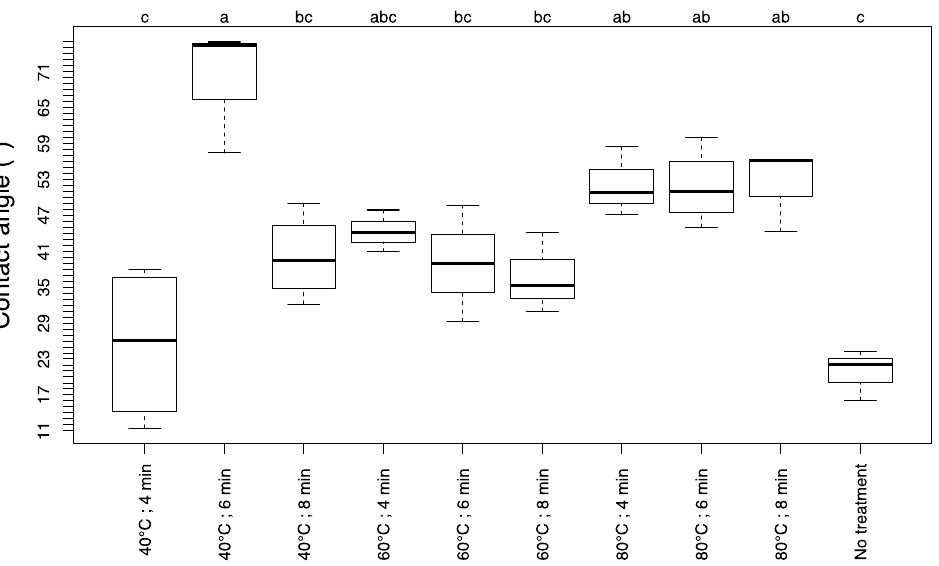
Figure 7. Influence of HPU treatments on wood hydrophobicity by contact angle measurements.